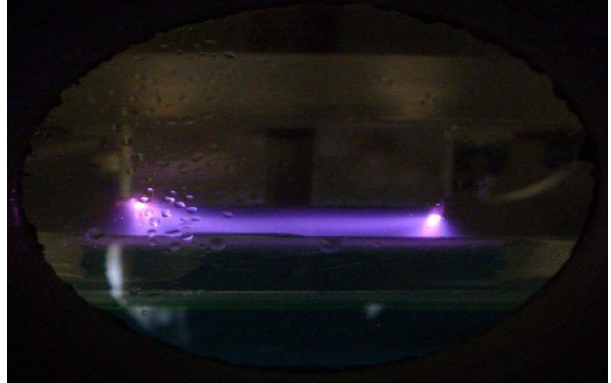
Figure 4. Image of the discharge above the surface of a 5% solution of a CuSO salt at an air pressure in the 4 discharge chamber of 6.5 kPa.